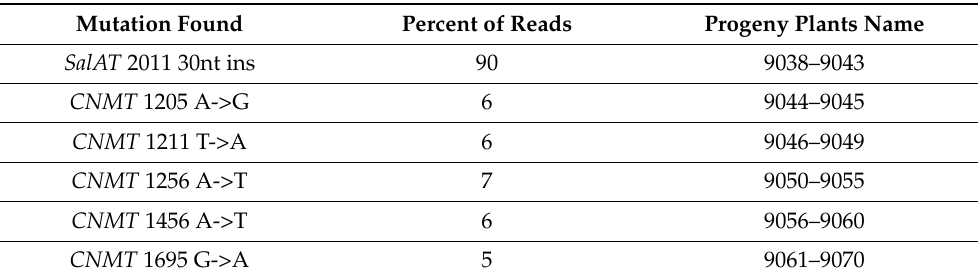
Table 2. List of mutations found in M2 generation in selected genes. Nucleotide positions within CDSs are indicated, ‘->‘ stands for substitution, and ‘ins’ for insertion. Mutation